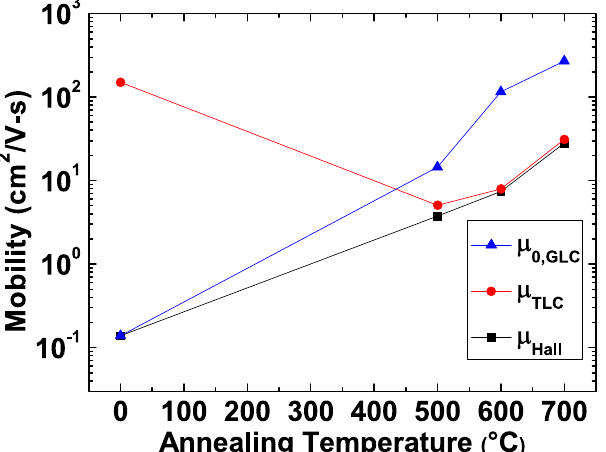
Figure 3. Measured μ Hall , extracted μ TLC and μ 0, GLC as a function of annealing temperature. μ Hall is entirely determined by μ 0, GLC for the as-deposited Cu 2 O thin film, whereas μ Hall is limited by μ TLC after high-temperature annealing, which suggests that GLC dominates before annealing and TLC becomes dominant after high- temperature